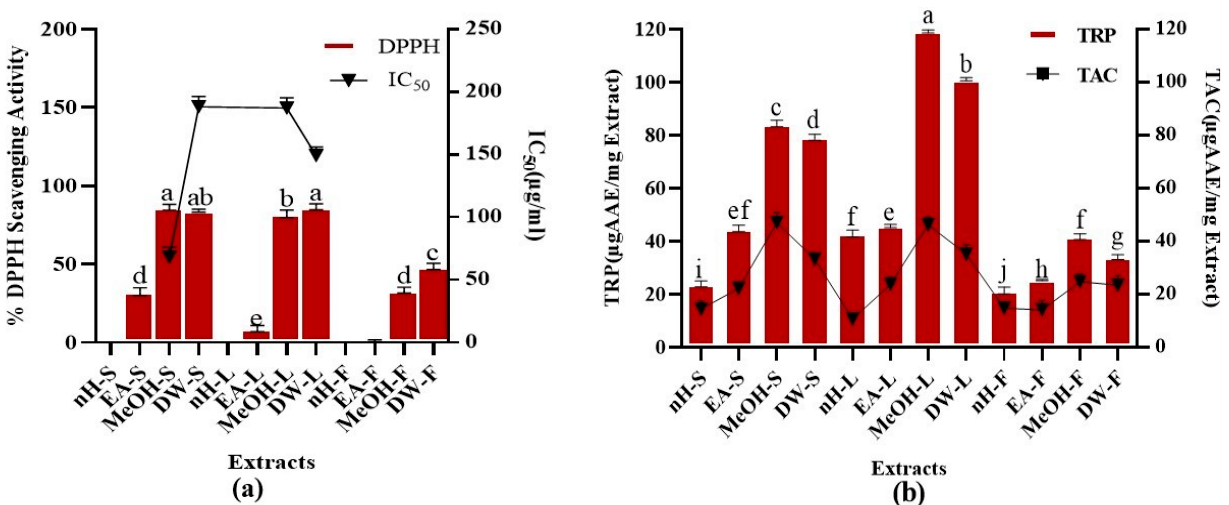
Figure 3. Demonstration of ( a ) %DPPH radical scavenging activity (at 40 μ g/mL concentration of test extracts) ( b ) TAC and TRP ( μ g AAE/mg) of P. roxburghii crude extracts. Assays were conducted in a triplicate manner and the data have been demonstrated as mean ± standard deviation. Significantly different means ( p < 0.05) are represented by different superscripts ( a–j ).